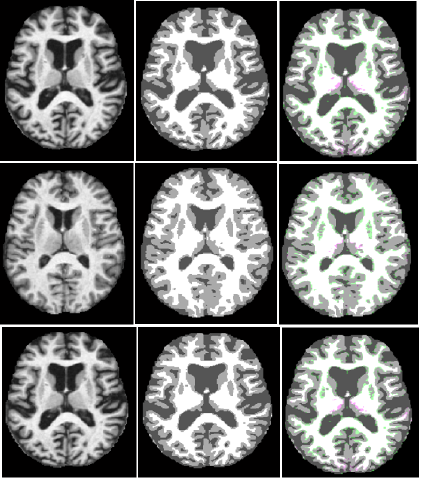
Figure 1. Segmentation results on OASIS dataset: first column, original image; second column, ground truth; and third column, segmentation result fused on ground truth. Table 1. Results comparison with state-of-the-art methods on OASIS dataset (Mean ± std).